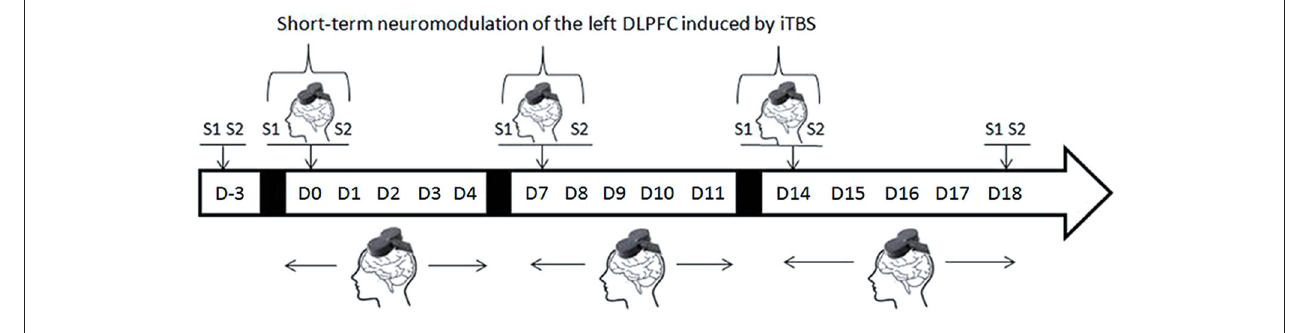
during the week but AS task sessions were performed only on the first day of each week, immediately before (S1) or immediately after (S2) rTMS treatment.